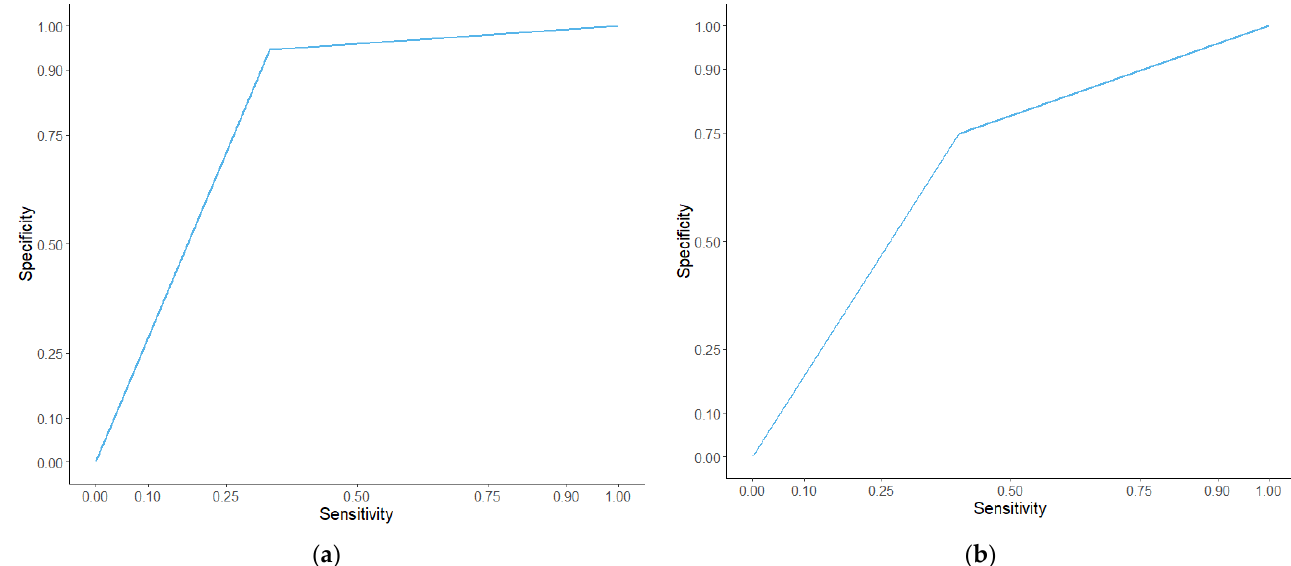
Figure 9. ROC curves of the Wellness Score in the discovery cohort ( a ) and the validation cohort ( b ) at six months. The Wellness Score was analysed using receiver operating characteristics curves. In the discovery cohort ( a ) the AUC for Wellness Score was 0.756 with a p value of 0.002. In the validation cohort ( b ) the AUC for Wellness Score was 0.675, with a p value of 0.018.